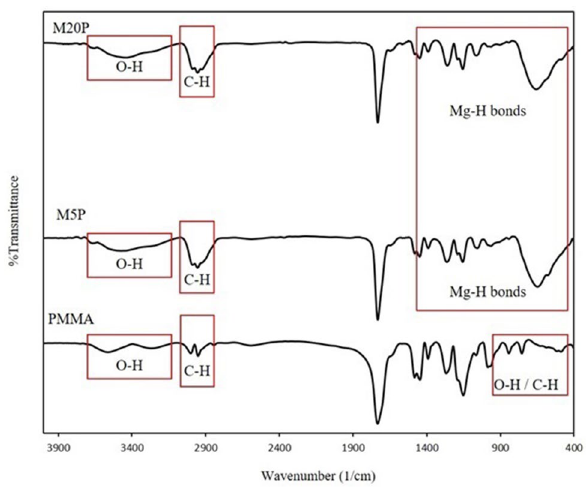
Fig. 3 FTIR spectra of PMMA (as received), M5P, and M20P sam- ples (see Table 1 for abbreviation)